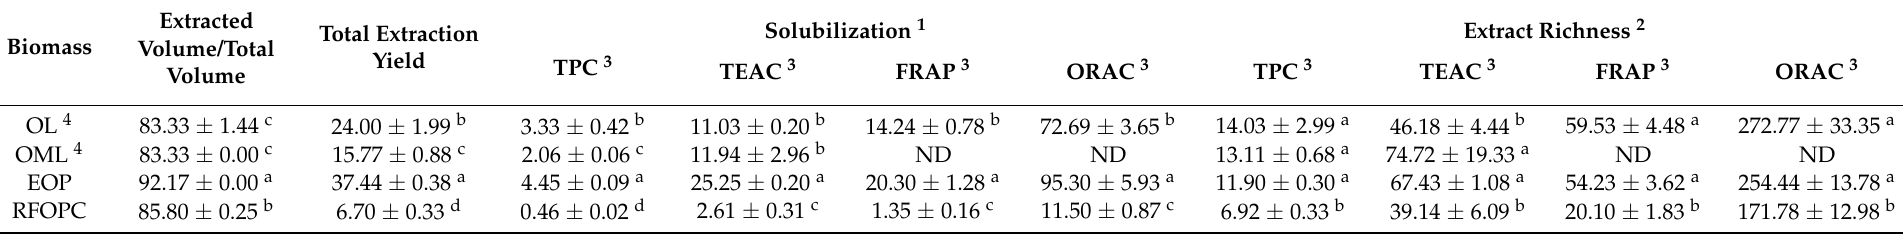
Table 2. Ratio of extracted volume (%), total extraction yield (%), total phenolic content (g of gallic acid equivalents/100 g), and antioxidant activity (mmol Trolox equivalents/100 g).